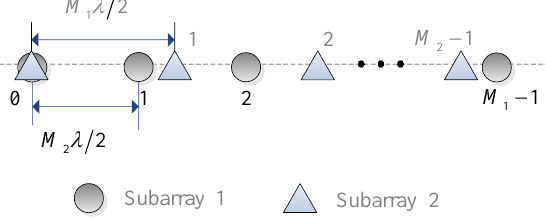
Figure 1. The system model of co-prime linear